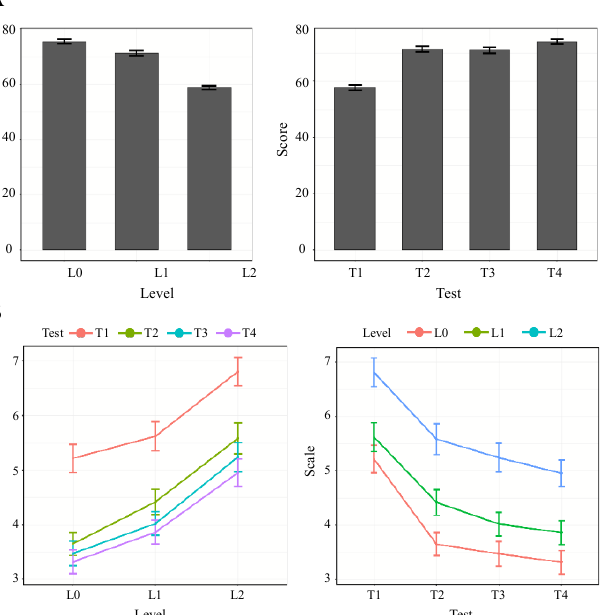
Figure 2. Summary of performance and subjective ratings across different conditions. ( A ) Behavioral results of UAV task. ( B ) Perceived workload result of UAV task. The error bars indicate the standard error of the mean (SEM).